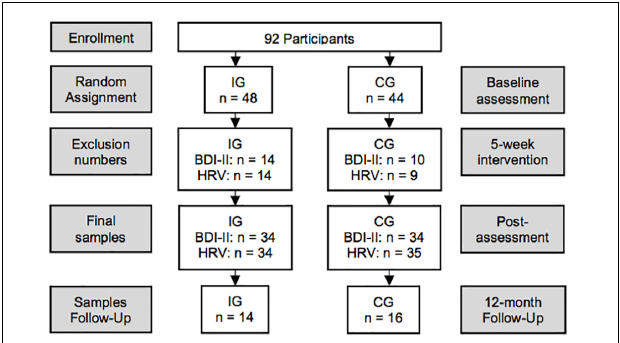
FIGURE 1 | Study design. N = 92 in-patients enrolled in the study and were randomly assigned to the intervention (IG) or control group (CG). Due to dropouts, missing items in the BDI-II, side effects from medication, illness, artifacts in the ECG, and missing assessments, the final sample size was reduced to 68 for the depression pre–post and to 69 for the HRV pre–post analyses, respectively. Overall, 30 participants (IG = 14; CG = 16) returned the follow-up